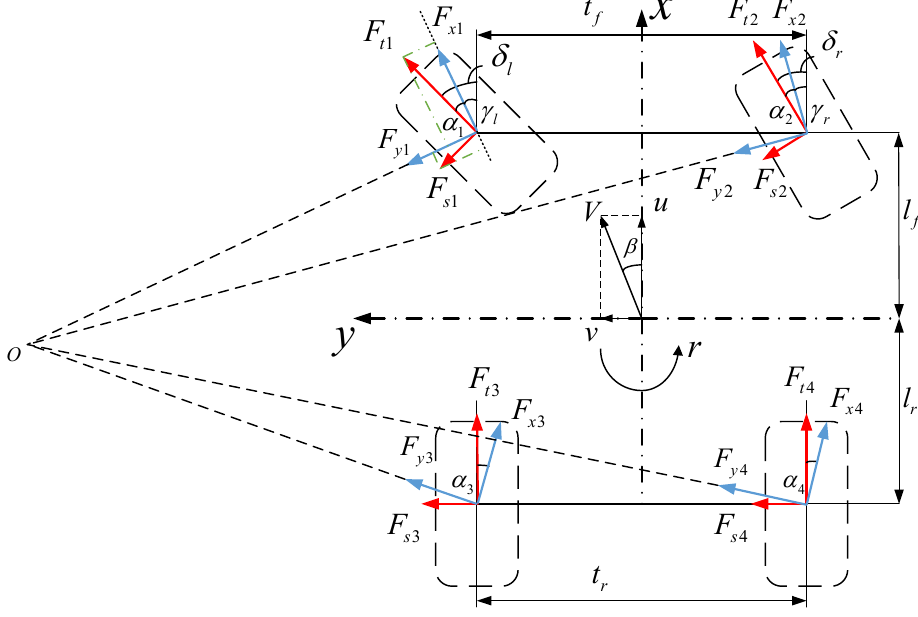
Figure 1. A 7 ‐ DOF vehicle dynamic model. Figure 1. A 7-DOF vehicle dynamic